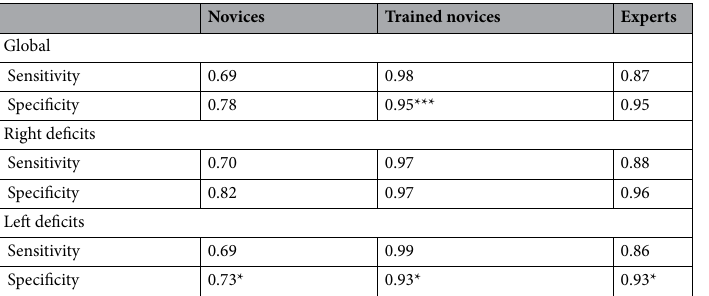
Table 1. Sensitivity and specificity of the HIT test. Performances evaluated on 560 tests for novices before and after training and on 112 tests for experts. Each side represented 260 tests for novices and 56 for experts. *p < 0.05 versus the right side, Fisher’s exact test. ***p < 0.0001 versus novices, Fisher’s exact